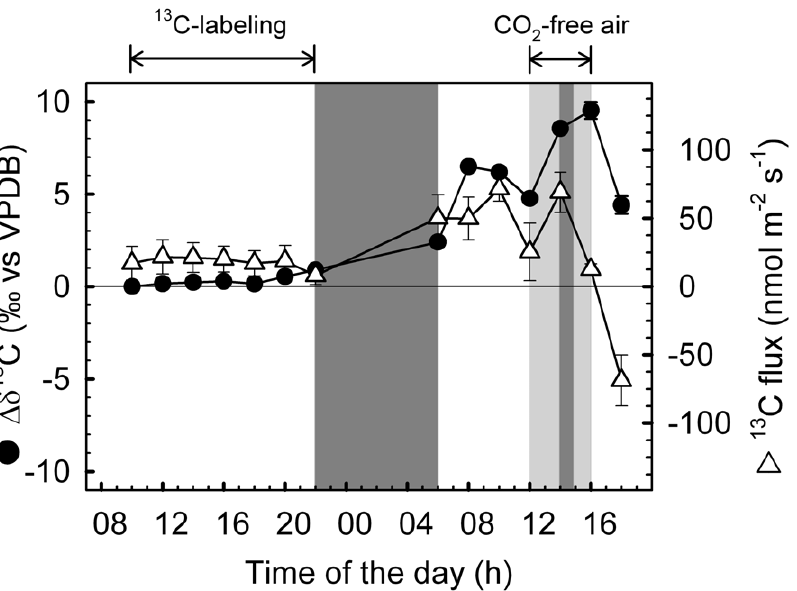
Figure 4. Calculated fluxes of 13 C-labeled sugars into the nutrient solutions of detached poplar shoots. 13 C enrichment (black circles) and fluxes (open triangles) of sugars into (positive values) and out of (negative) the nutrient solution of shoots labeled with 13 CO 2 . The dark phase is indicated with dark grey color. Data represent the mean of 3 experiments 6 s.e.